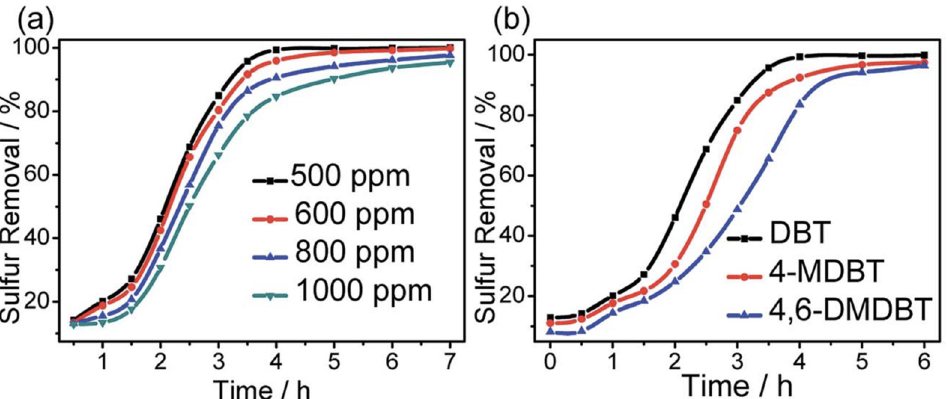
Figure 3. Sulfur removal of oils with different S-concentrations ( a ), and substrates ( b ). Experimental conditions: T = 120 °C, V (oil) = 50 mL, V (Bmim]BF4) = 5 mL, m (catalyst) = 0.05 g, v (air) = 100 mL min − 1 [71].